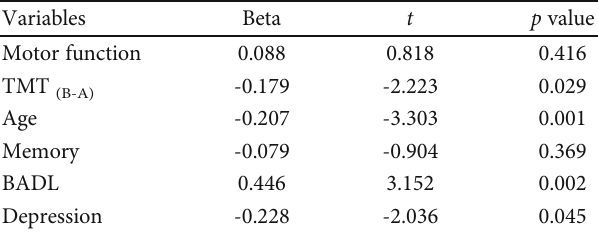
Table 4: Linear regression analysis of IADL level.